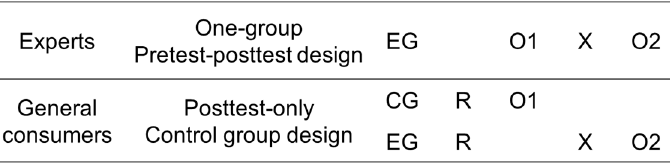
Figure 1. Experimental